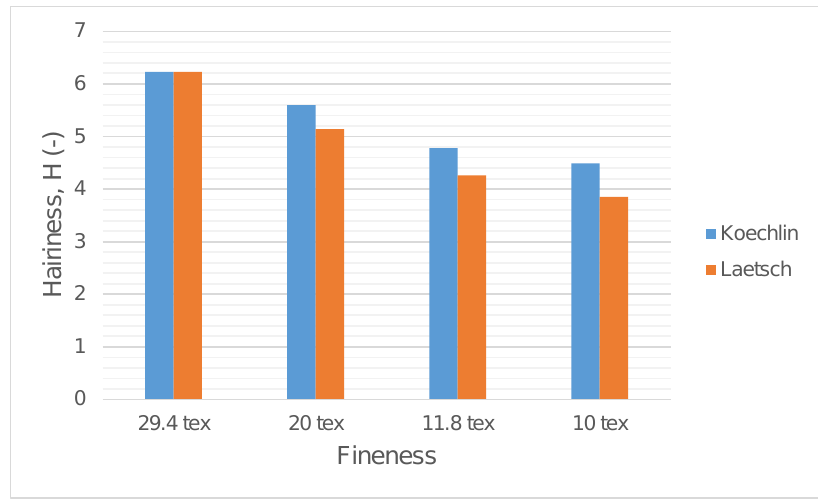
Figure 9. Yarn hairiness as a function of number of turns per meter and yarn fineness.